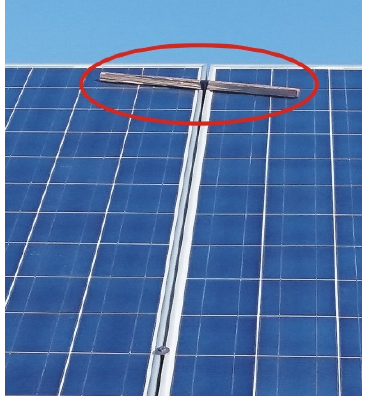
Figure 9. Improper panel mounting [24].